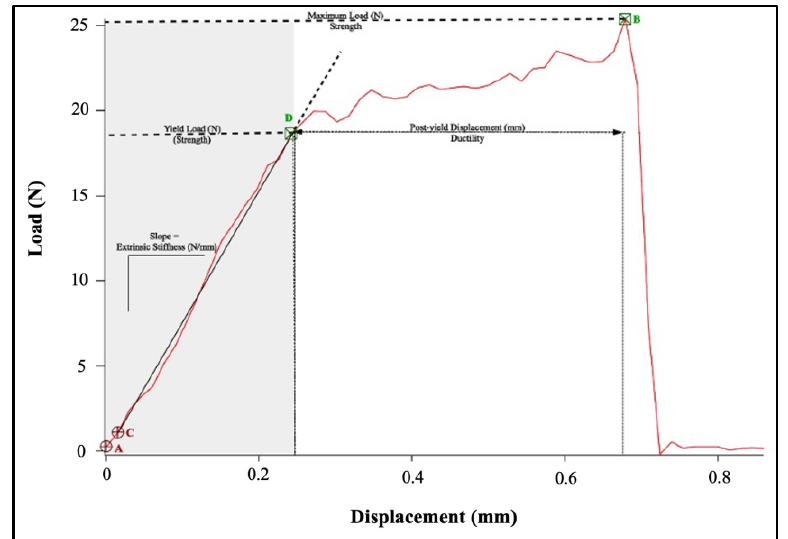
Figure 4. An example load-displacement curve in IgorPro. The entire curve from the beginning of the test to the fracture point is bound by the cursors A,B. Cursor B specifically marks the maximum load. Cursors C,D show the portion of the linear elastic region used to measure stiffness. The entire linear elastic region is shaded in grey. Cursor D also marks the yield point. All area not shaded in grey, past the yield point, is the plastic region.